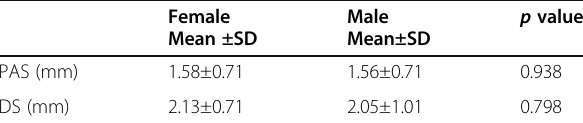
Table 5 Comparison of the total amount of retraction by gender p value Female Male Mean ±SD Mean±SD PAS (mm) 1.58±0.71 1.56±0.71 0.938 DS (mm) 2.13±0.71 2.05±1.01 0.798 PAS power arm sliding, DS direct sliding p